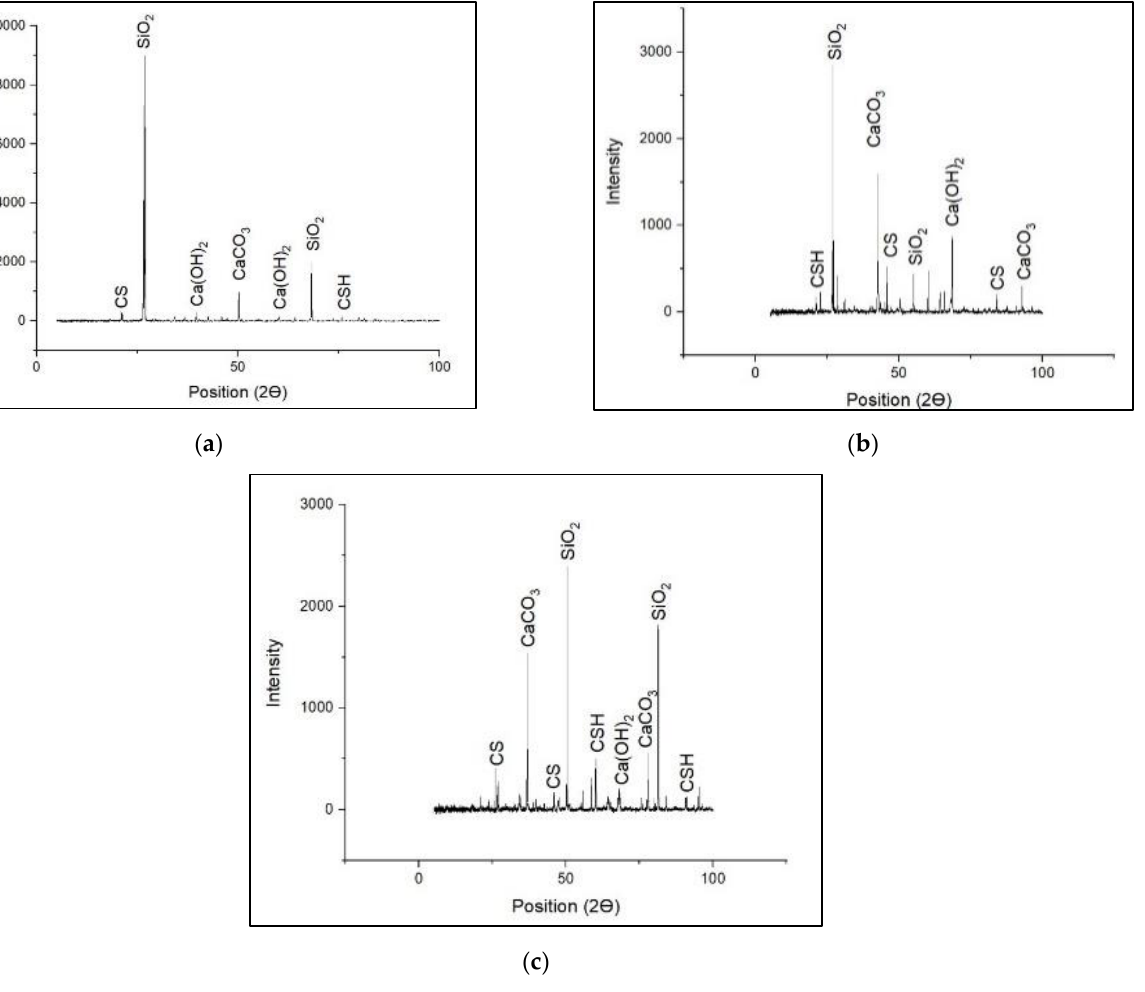
Figure 23. XRD results of mortars. ( a ) Conventional mortar; ( b ) Brass fibre added mortar; ( c ) Brass – carbon hybrid fibres added mortar. carbon hybrid fibres added